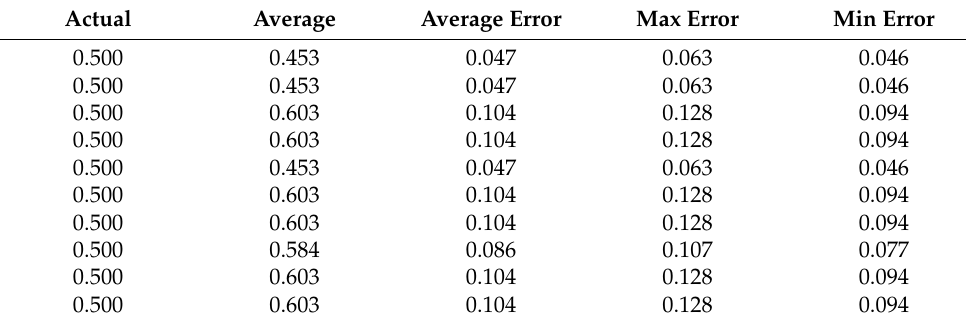
Table A159. Set 3, trials 1–10 data (all 0.5 PR values).